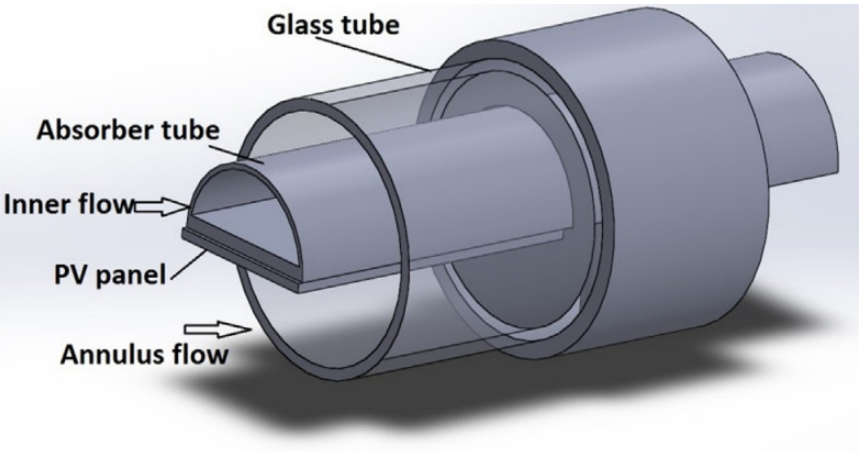
Figure 25. Model of designed hybrid receiver tube [111]. Reprinted with permission from Ref. [111]. 2020, Elsevier.